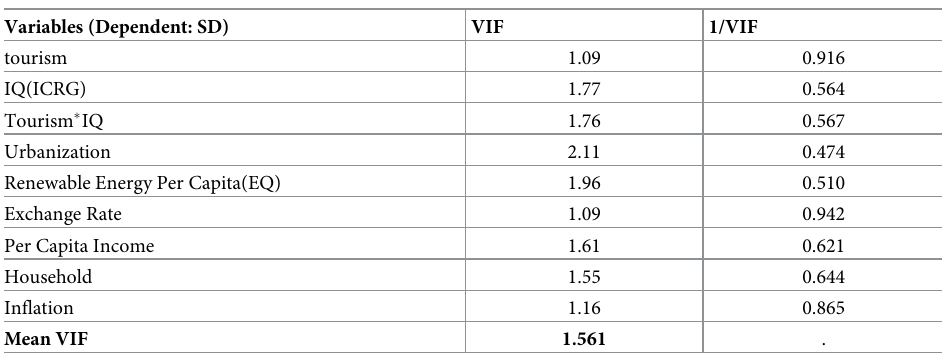
Table 2. Variance inflation factor.